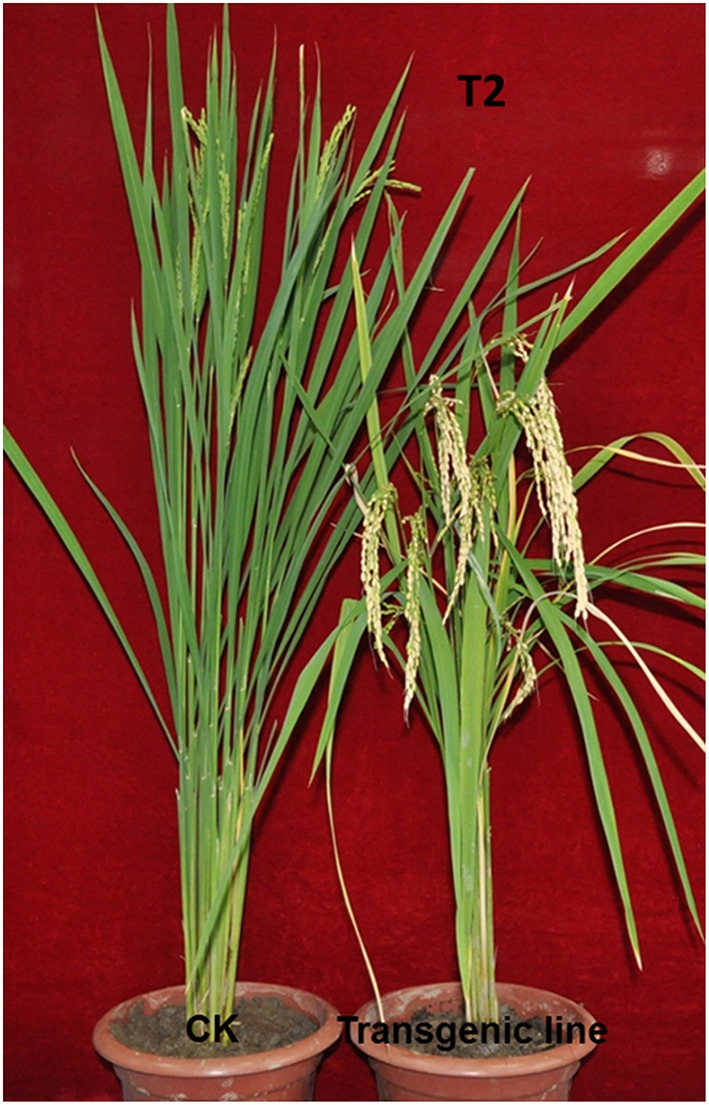
Comparison of T2 transgenic (right) and control (left) plants (cv. Nipponbare).